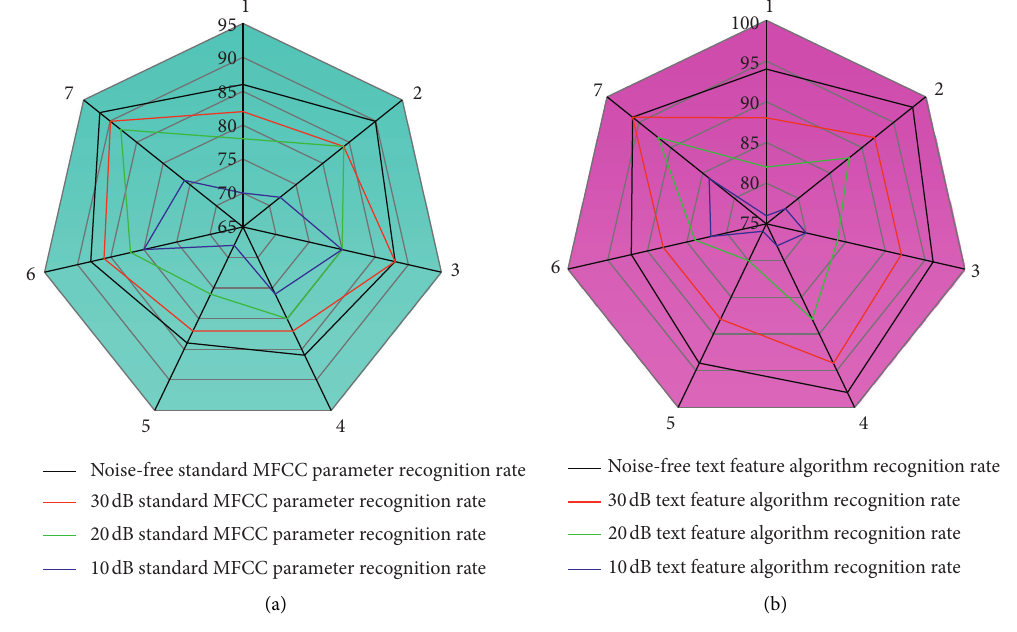
Figure 6: System identification results: (a) the first type and (b) the second